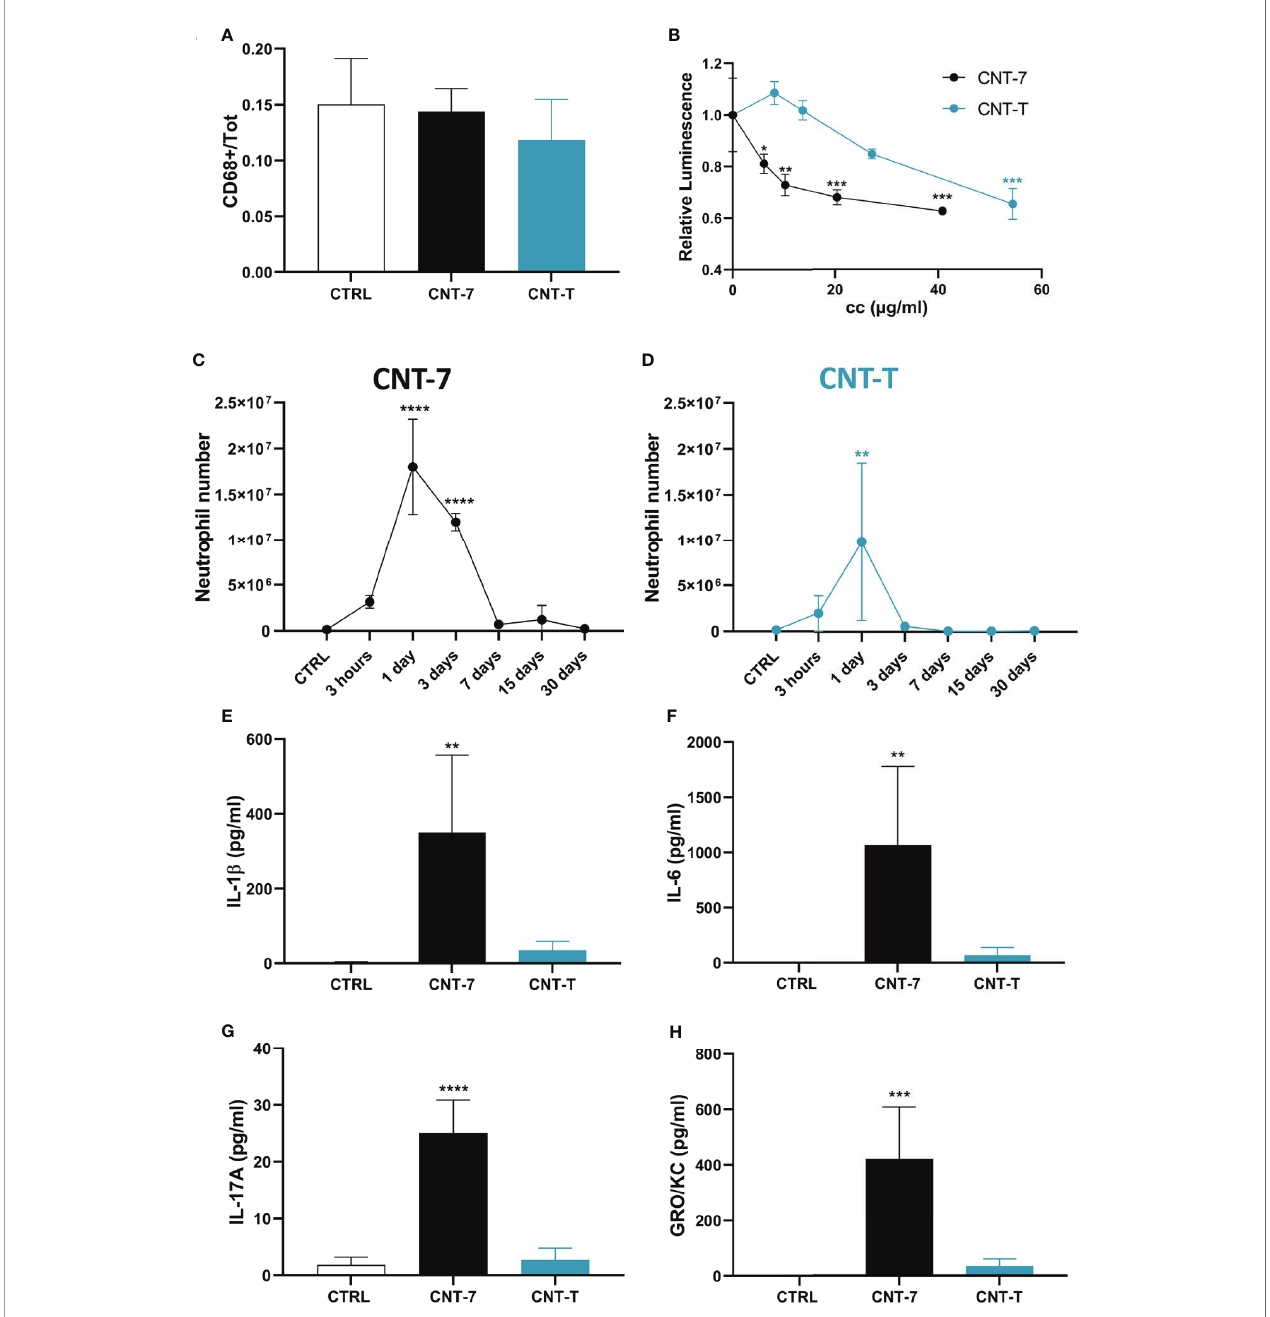
FIGURE 2 | An early cytotoxicity but not a relocation in the omentum explains the CNT-induced disappearance reaction (MDR) and in fl ammatory responses. (A) Quanti fi cation of CD68-positive cells of the omentum of untreated and CNT-7 or CNT-T-treated rats (2 mg, I.P.) sacri fi ced after 1 hour. The immuno fl uorescent staining was performed with anti ‐ rat CD68 antibody. (B) Cellular ATP levels measured 24 hours after in vitro exposure of naïve peritoneal macrophages to 20, 10, 5 and 3 m g/ml of mesotheliomagenic CNT-7 or non-mesotheliomagenic CNT-T. ATP concentration was measured with CellTiter-Glo ® Luminescent Cell Viability Assay. Each point represents the mean of 3 replicates ± SD. (C, D) Number of peritoneal neutrophils (see Figure 1 A, frame b) in response to CNT-7 and CNT-T (2 mg, I.P.) (day 0-30). CTRL are untreated rats sacri fi ced at 3 hours. Each point represents the mean of 4 samples ± SD. (E – H) IL-1 b , IL-6, IL-17A and GRO/KC released in untreated and CNT-7 or CNT-T-treated rat (2 mg, I.P.) peritoneal fl uids at 3 hours were tested using Bio-Plex multiplex assay. The results were statistically analysed using ANOVA test followed by Dunnett ’ s test. (*) p = 0.0332, (**) p = 0.0021, (***) p = 0.0002, (****) p < 0.0001 indicates a statistically signi fi cant difference with